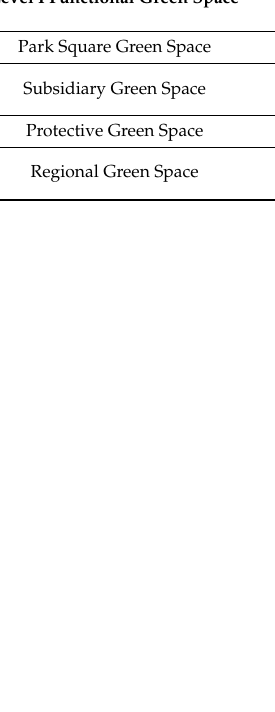
Table 3. The five ESFs provided by six functional UGS. Level I Functional Green